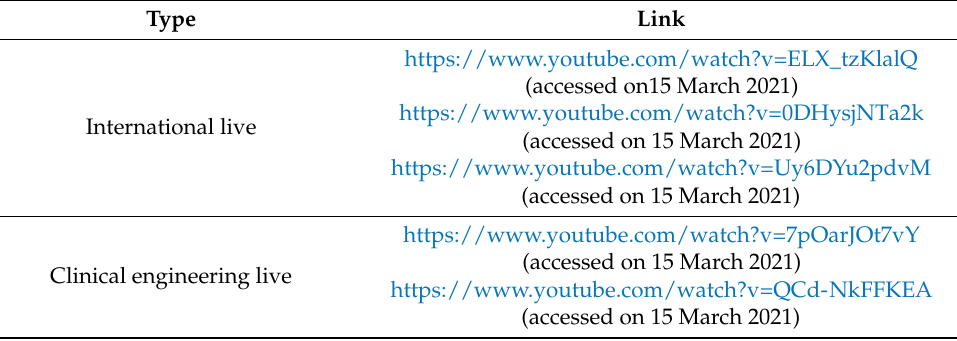
Table A2. Training and knowledge transfer